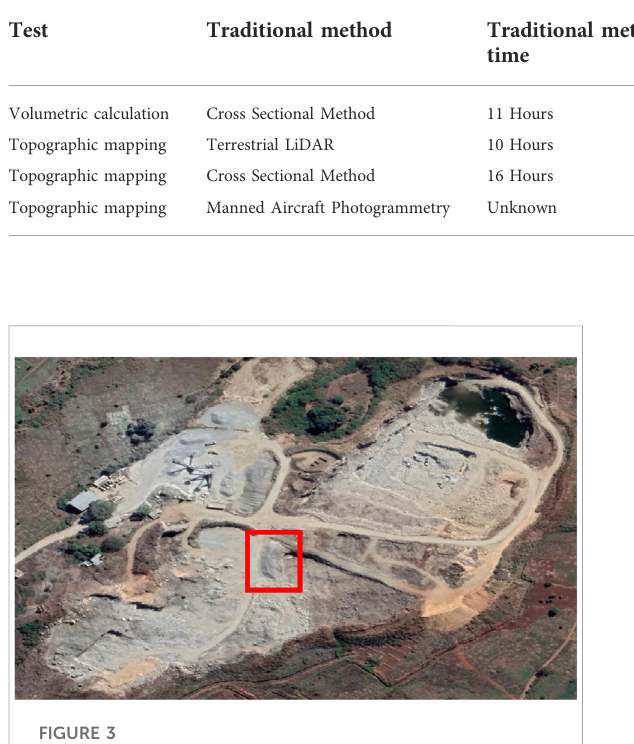
TABLE 1 Comparison of UAS and Traditional survey approaches (Fitzpatrick, 2015).